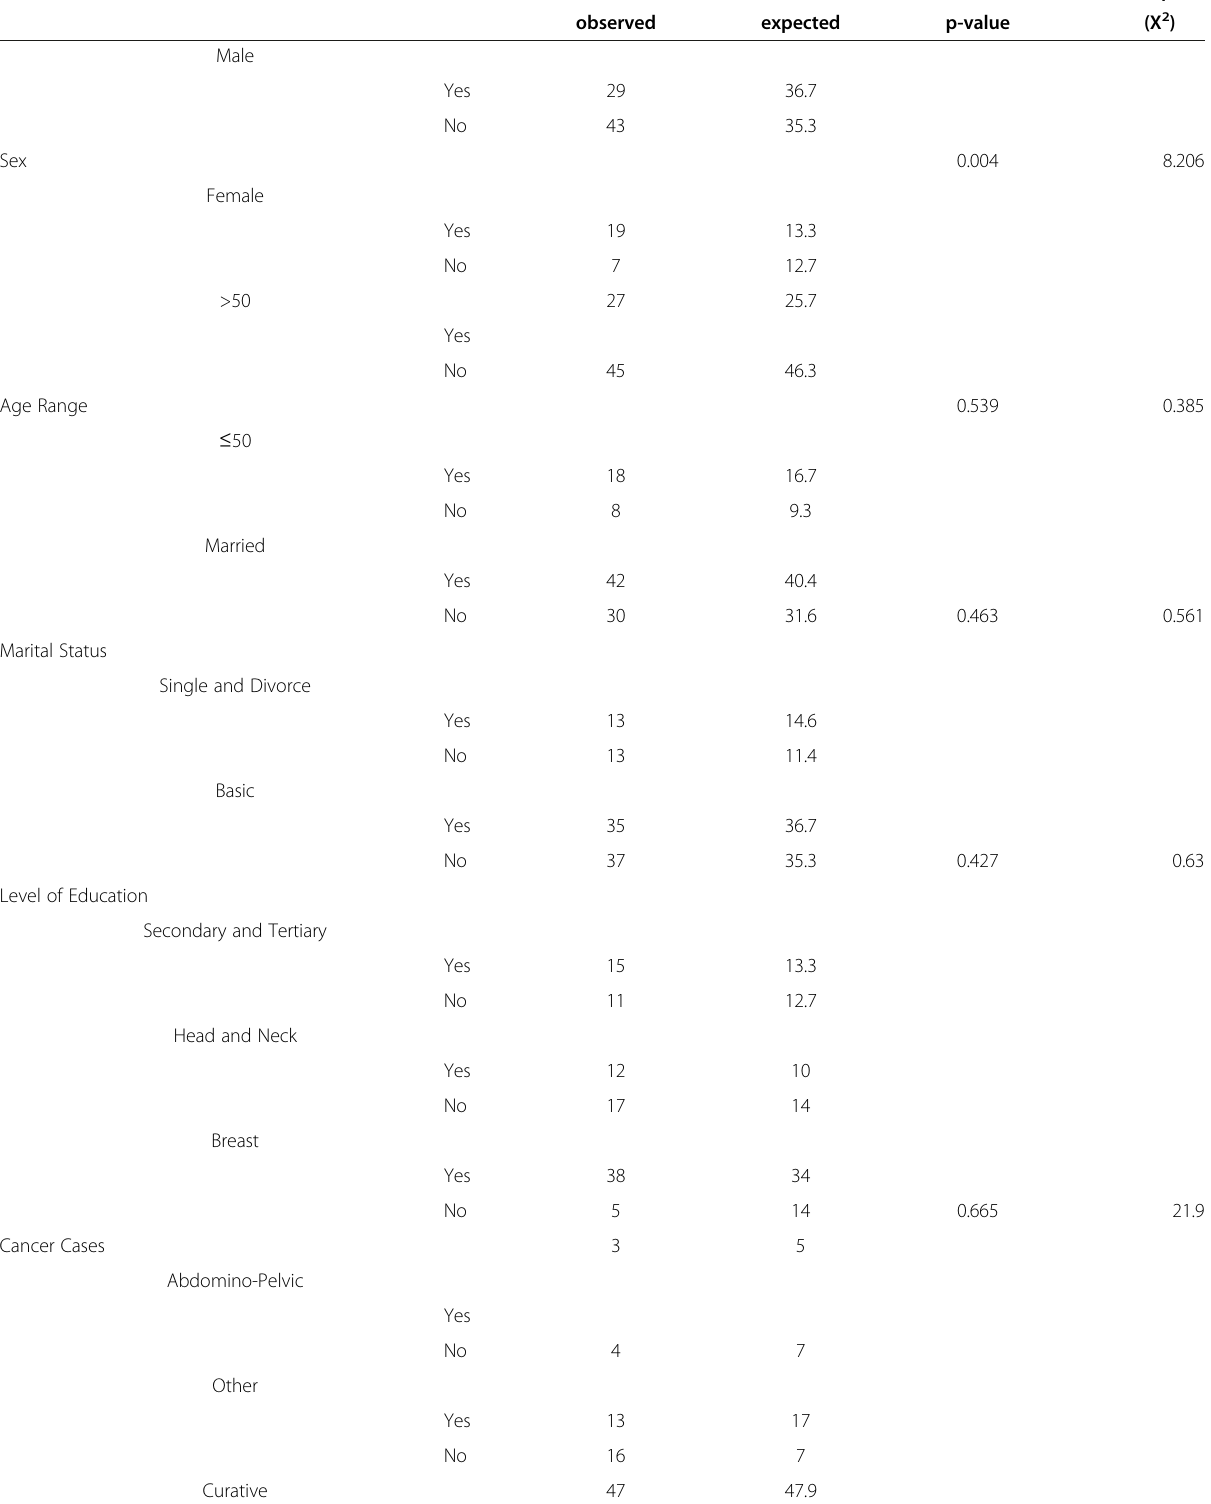
Table 2 Contingency table of Patient characteristics and CAM